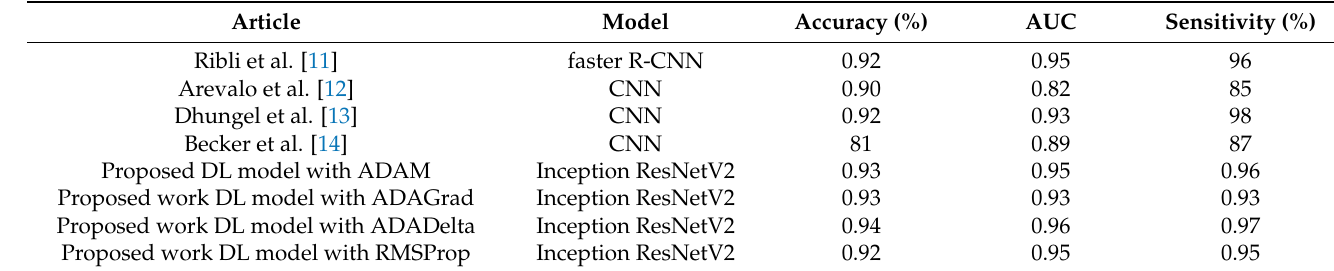
Table 5. Comparison of the proposed model with existing